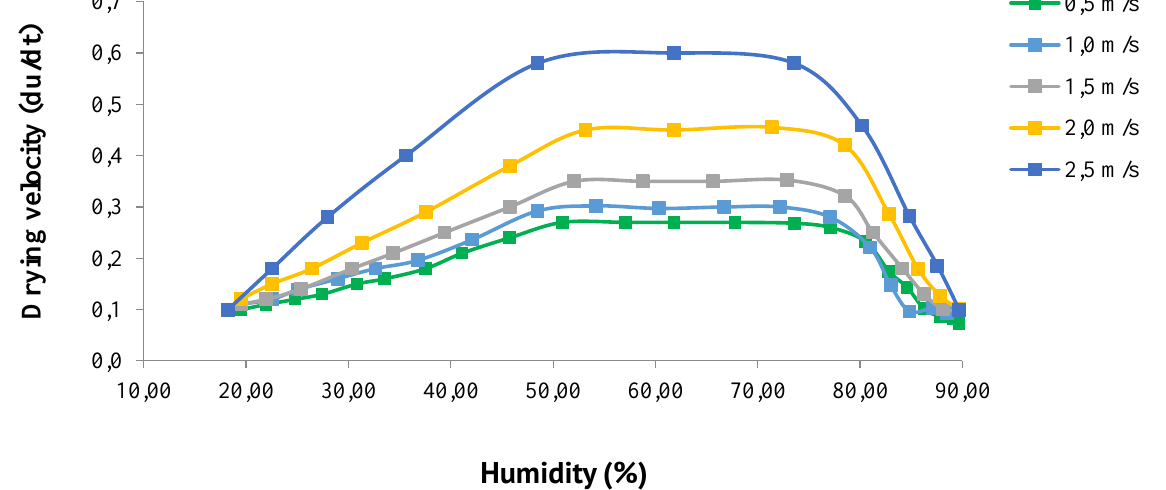
Figure 9. Peaches different thermal agent velocities drying velocity curves (Thermal agent relative humidity 65.0%, thermal agent temperature 60°C, slices thickness 3 . 10 -3